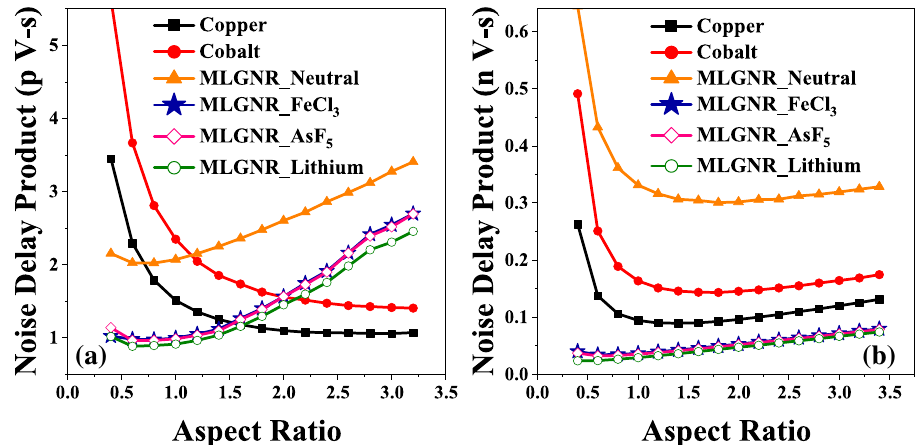
Figure 5. Optimized AR at minimum noise delay product in ( a ) intermediate level (L = 10 µ m) and ( b ) global level (L = 1 mm) interconnects.